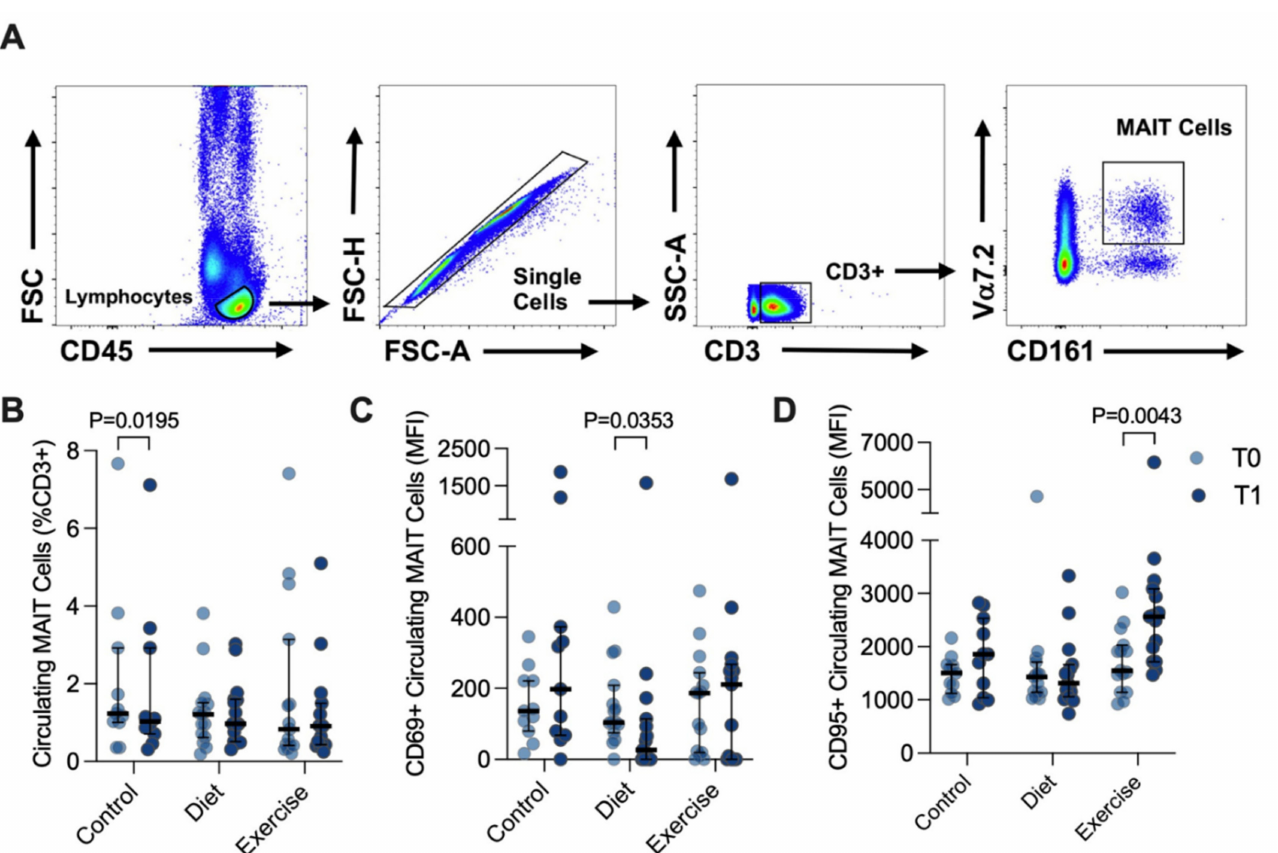
Figure 3. Circulating MAIT cells before (T0) and after (T1) diet or exercise intervention. ( A ) Repre- sentative flow cytometry dot plots showing gating strategy for defining circulating CD3 + V α 7.2 hi CD161 hi MAIT cells. ( B ) Circulating MAIT cells in control participants ( n = 11, as 3 participant samples were lost during processing), and participants completing either 12 weeks of dietary ( n = 15) or exercise ( n = 15) intervention. ( C ) CD69+ and ( D ) CD95+ circulating MAIT cells before and after intervention. Data were analysed via Wilcoxon matched pairs signed-rank test, and individual values and median ± interquartile range are depicted. MFI: median fluorescence intensity. MAIT: Mucosal-associated invariant